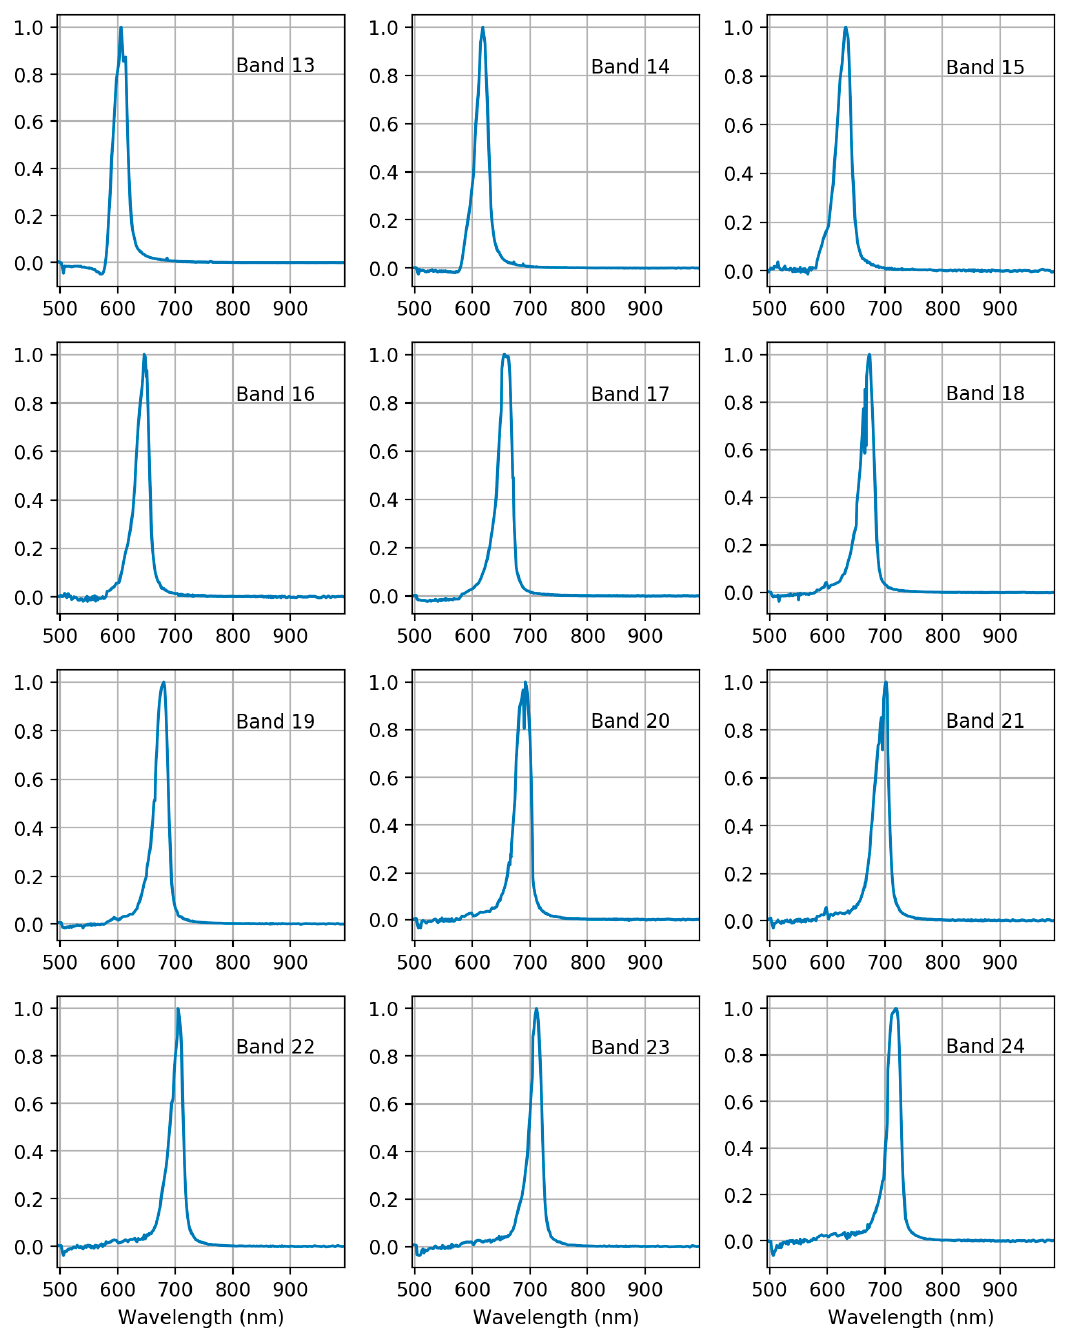
Figure A2. FPI spectral response curves for bands 13–24. Curves are scaled so that the maximum value is 1.